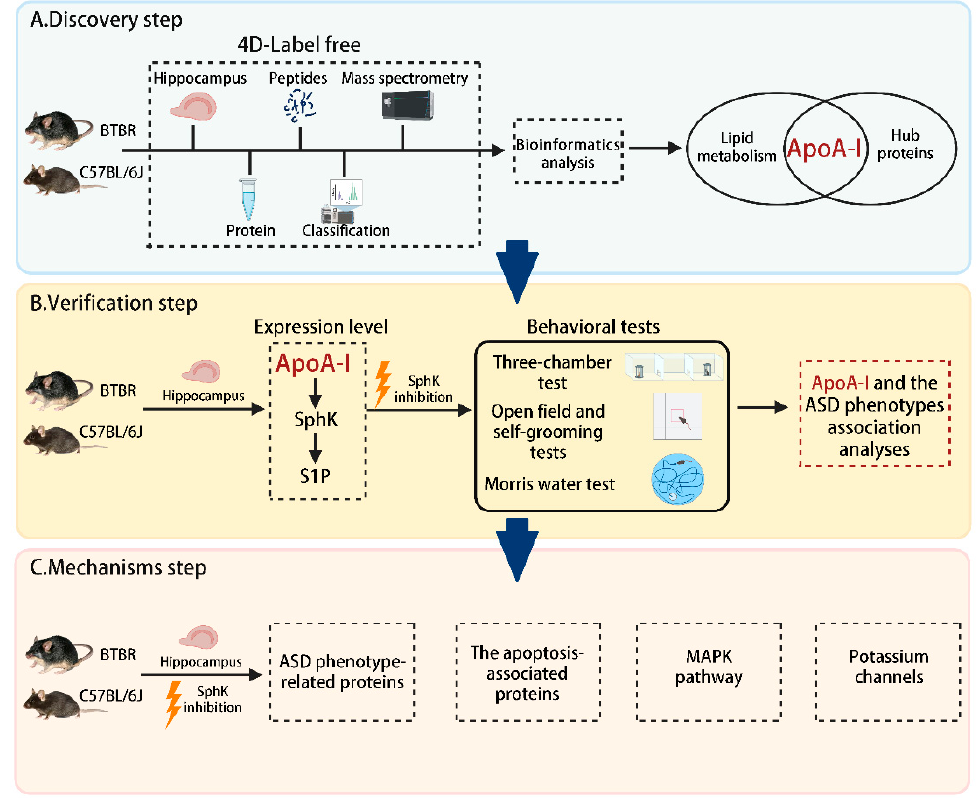
Figure 1. Overall workflow diagram for discovering and verifying the roles and mechanisms of ApoA-I-related